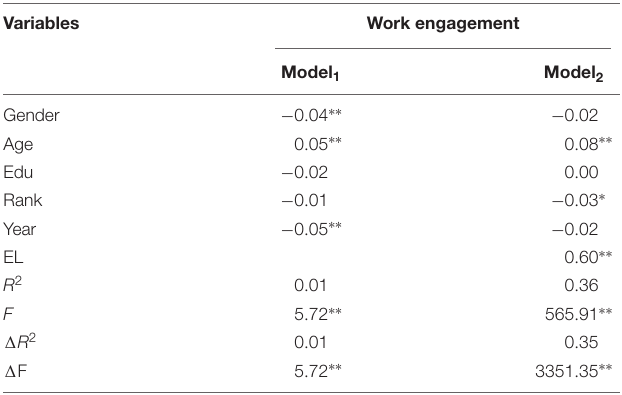
TABLE 2 | Mediation